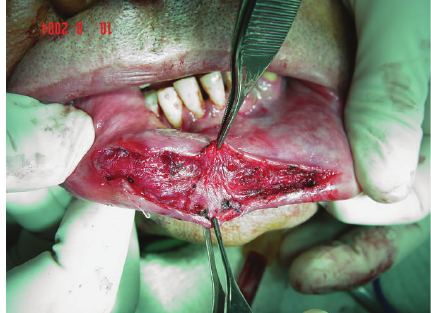
Figure 6: Surgical bed after excision of the artery revealing the absence of bleeding.